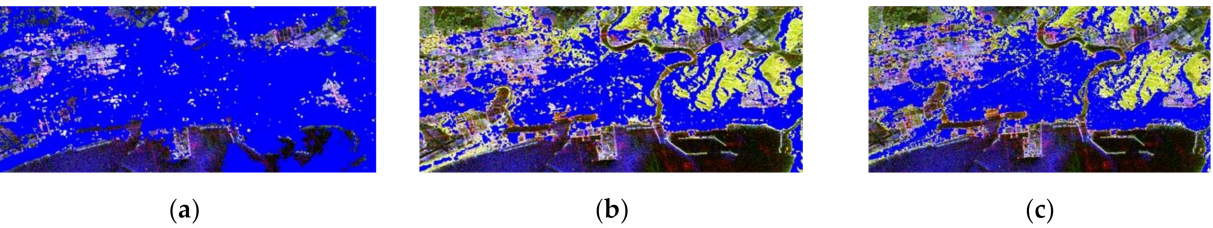
Figure 26. The results of non-building area removal in Ishinomaki with different methods: ( a ) the H − α method; ( b ) the H − α − wishart classification method; ( c ) the proposed method.